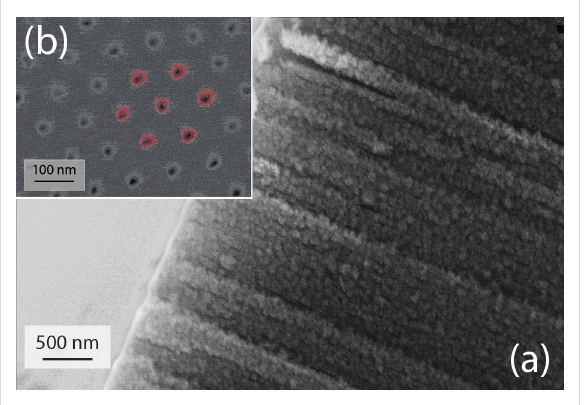
Figure 3: (a) SEM cross section of a NiO layer deposited in AAO membrane. (b) SEM image (obtained in backscattering electron mode) showing NiO grown by ALD within the AAO template. The NiO top layer has been removed by a short Ar sputtering in order to reveal the NiO film coating the vertical pore walls. The NiO deposit is empha- sized on the picture using a red overlay.